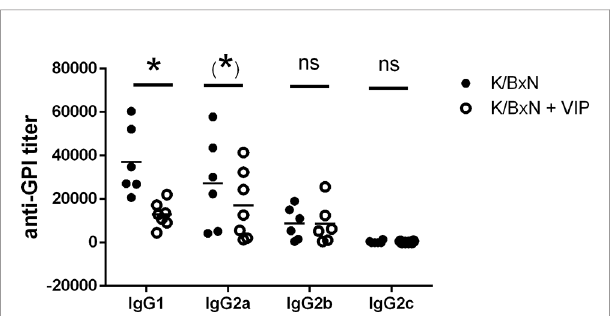
FIGURE 4 | mRNA expression of master transcription factors of different Th cell subsets of PBS or VIP treated K/BxN mice. The expression was determined by quantitative real-time PCR as indicated (supplemental materials). Mean is shown as the horizontal line within each group; each symbol represents an individual mouse. *p < 0.05; ns, not signi fi